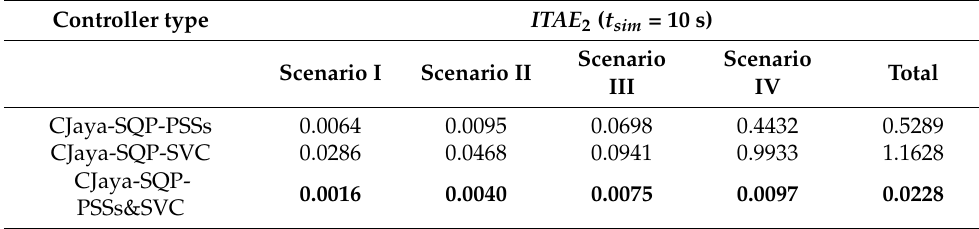
Table 16. Numerical results of ITAE 2 performance index for four suggested